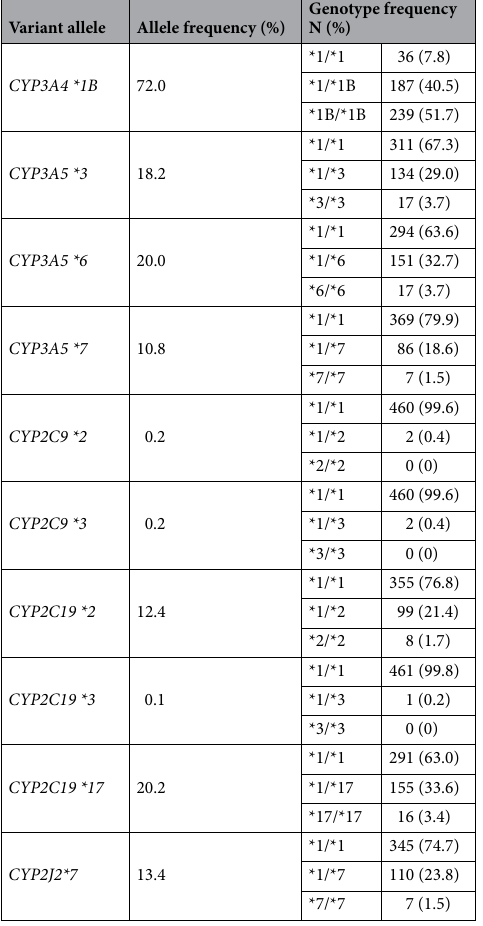
Table 1. Genotype and allele frequencies for CYP3A4 , CYP3A5 , CYP2C9 , CYP2C19 and CYP2J2 in the study population.